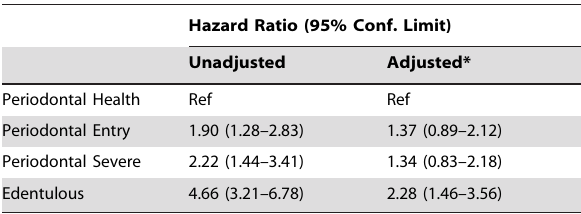
Table 4. Hazard Ratios for COPD Related Events.